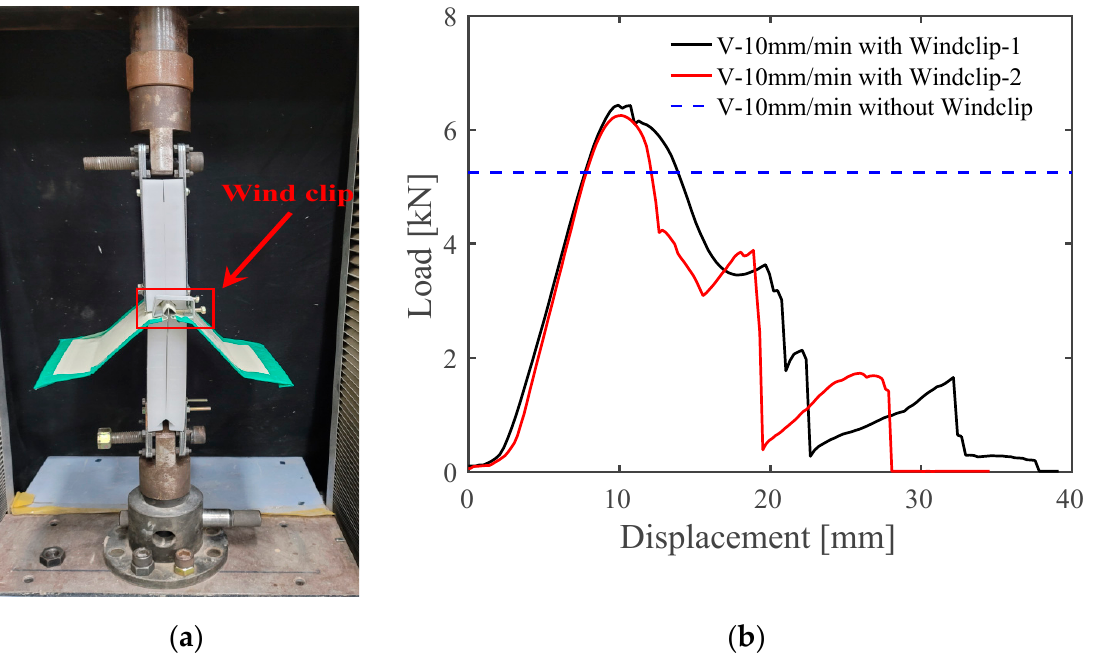
Figure 10. Experimental set-up for the strengthened lab-scale tests. ( a ) Schematic design; ( b ) load vs. displacement curves with wind clips. Table 4. Experimental results of lab-scale SSMR tests with wind clips.